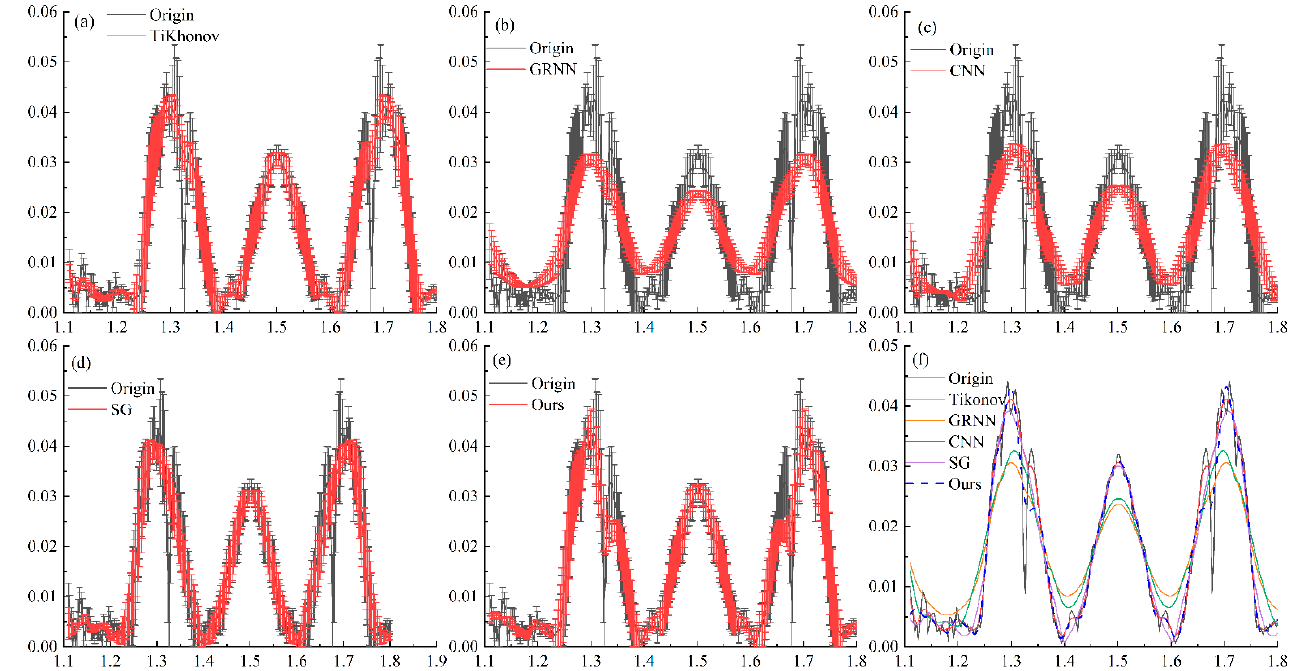
Figure 10. The restored effect of region B. ( a – e ) Comparison of real THz spectra with Tikhonov, GRNN, CNN, SG, and the proposed method, respectively. The error bars are calculated from the standard deviation. ( f ) The denoising effect without error bars.